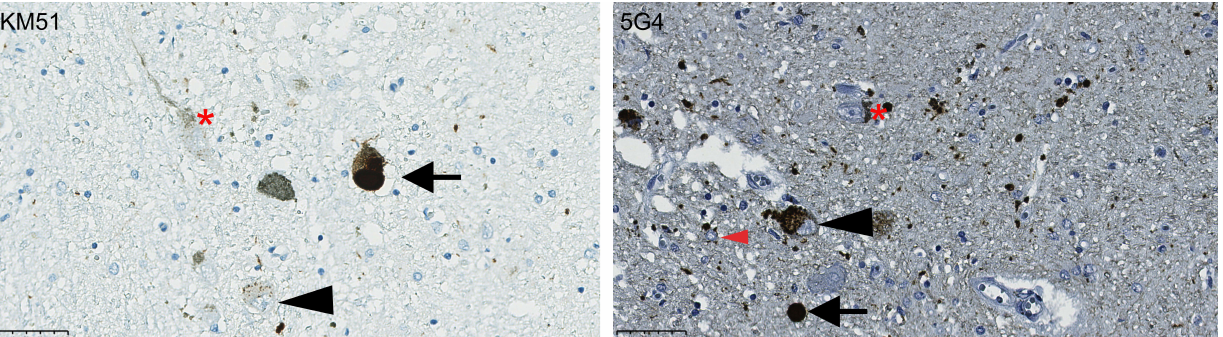
Figure 1. Immunostaining of the SNc with antibodies against full-length α -synuclein (KM51) or ag- gregated α -synuclein (5G4). Representative images of immunostaining against full length synuclein (KM51) and aggregated synuclein (5G4) in sections from the SNc of the same individual. Arrowheads show punctate inclusions, arrows show cytoplasmic and extracellular Lewy bodies and dense bodies. There is a higher level of immunopositive grains and threads, as well as inclusions in glial cells (recog- nized based on morphology; red arrowhead) in tissue stained with the 5G4 antibody. Neuromelanin is marked with an asterisk. Scalebar: 50 µ